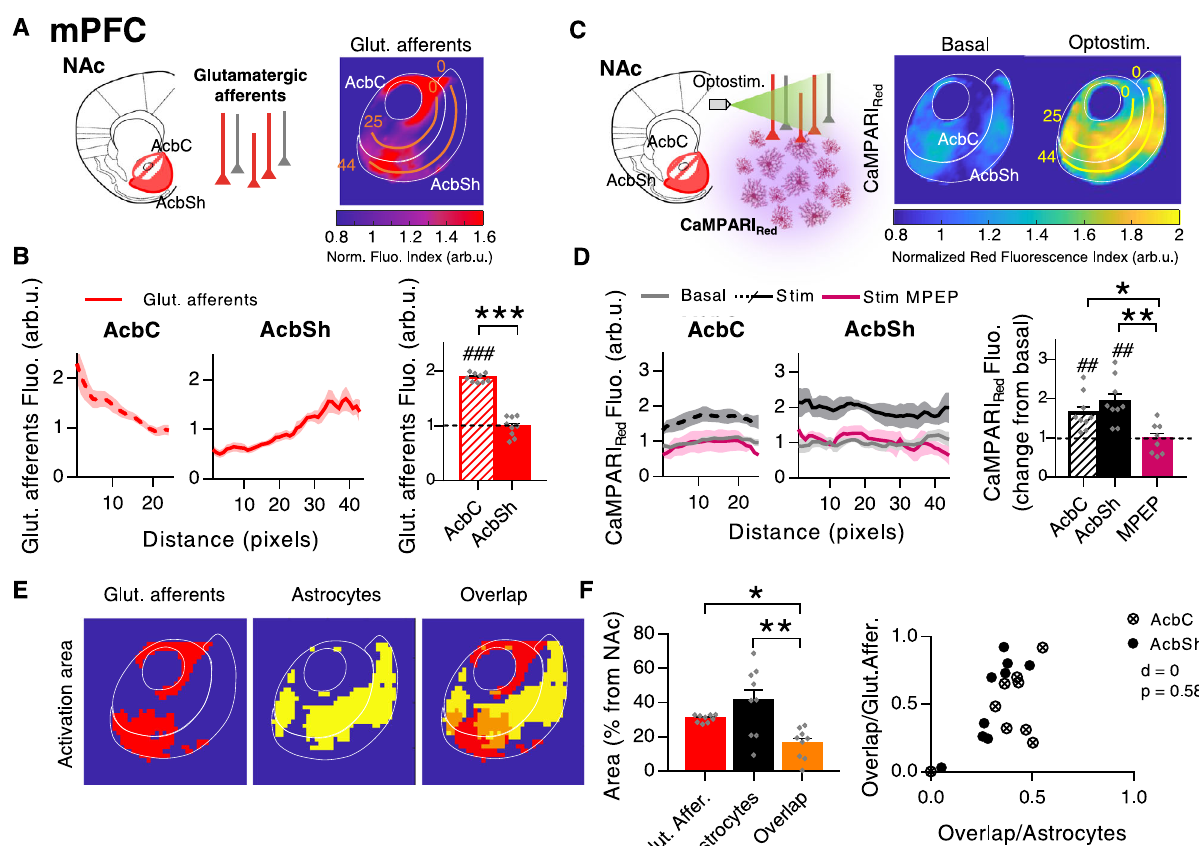
Fig. 3 | Spatial nucleus accumbens (NAc) astrocytic response to medial pre- frontal cortex (mPFC) afferents. A Left, scheme of opsin-transfected mPFC afferents in the NAc. Right, average PRQ image showing mPFC glutamatergic innervationpattern.Orangelinesstartingfrompixel0ineachsubregionwereused for quanti fi cation (pixel=50 µ m 2 ). B Left, Glut. afferents fl uorescence (arb.u.) vs distance (pixels) quantifying mPFC innervation across orange lines. Right, average glutamatergic afferents spatial fl uorescence (arb.u.) in the accumbens core (AcbC; slashedbar)andaccumbensshell(AcbSh;solidbar)(9slices,6mice).One-sample t test, ### P <0.001; two-tailed unpaired t test, *** P <0.001. C Left, scheme of astro- cytic Ca 2+ activity, measured by CaMPARI GFAP red, in response to mPFC afferent ’ s optostimulation.Right,averagePRQimageshowingastrocyticactivationpatternin the NAc in basal and optostimulated conditions. Yellow lines starting from pixel 0 ineachsubregionwereusedforquanti fi cation(pixel=50 µ m 2 ). D Left,CaMPARI Red fl uorescence (arb.u.) vs distance (pixels) quantifying astrocytic activation across